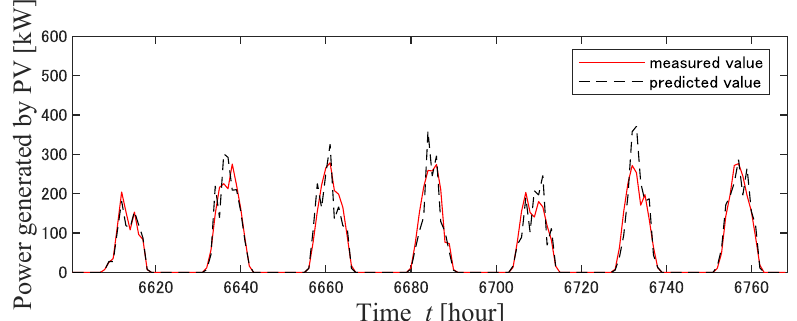
Figure 11. Power generated by PVs (winter).